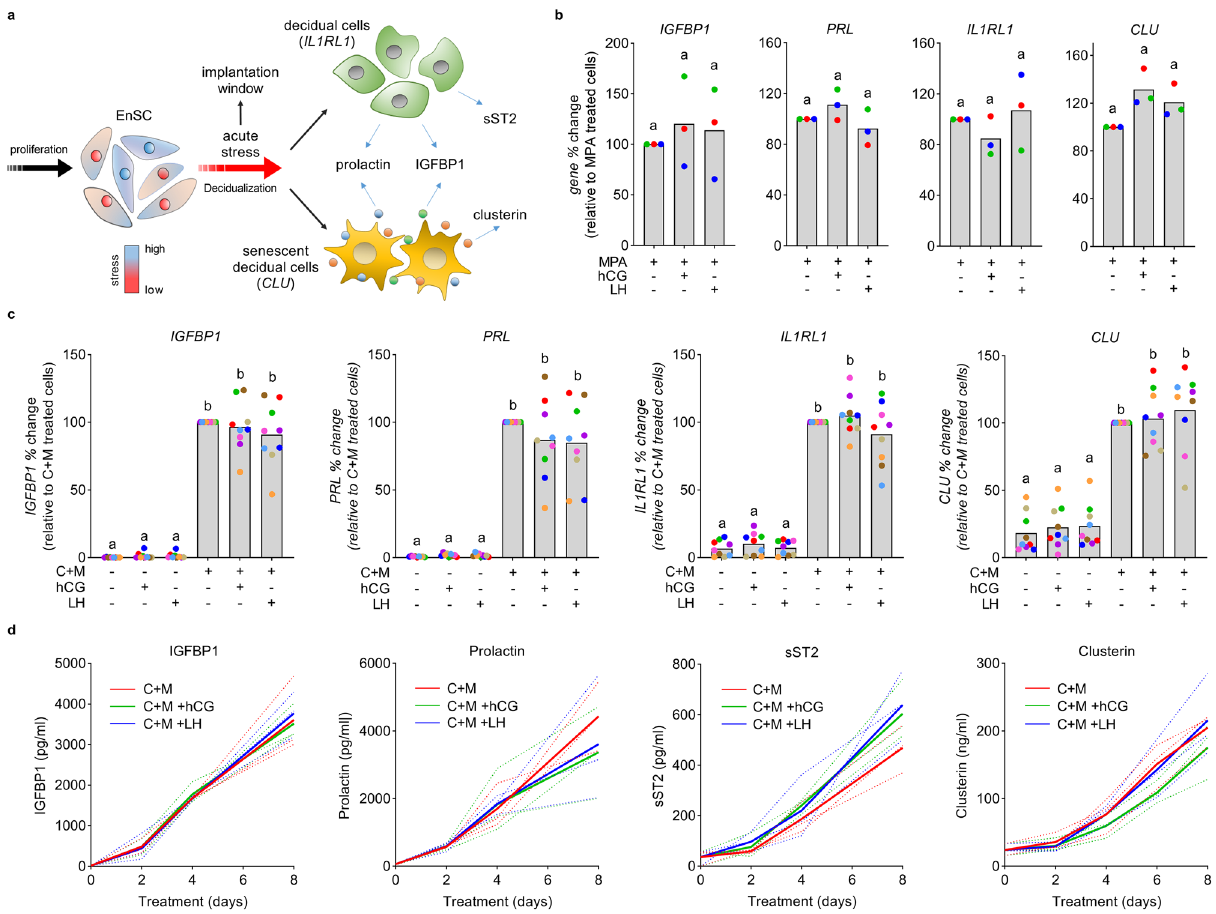
Figure 5. hCG and LH have no effect on EnSC decidualization. ( a ) Schematic representation of the emergence of decidual and senescent decidual cells and the genes and secreted factors associated with each population. Modified with permission from Kong et al. 9 . ( b ) RT-qPCR analysis of markers for decidualization ( IGFBP1 and PRL ) and decidual ( IL1RL1 ) and senescent ( CLU ) EnSC after 8-day treatment with 10 nM hCG or LH in combination with MPA. ( c ) Impact of 10 nM hCG and LH on the induction (C + M treatment) of decidual ( IGFBP1 and PRL ) and population specific ( IL1RL1 and CLU ) marker genes (n = 9). Data are shown as individual biological replicates from independent cultures with bars denoting mean values. Different letters indicate statistical differences ( P < 0.05) between groups (ANOVA and Dunnett’s multiple comparison test). ( d ) Impact of 10 nM hCG and LH on the decidual induction (C + M) of secreted factors in EnSC. Plots from individual patients are shown with bold lines indicating mean. Data are non-significant via two-way ANOVA and Dunnett’s multiple comparison test using C + M as the